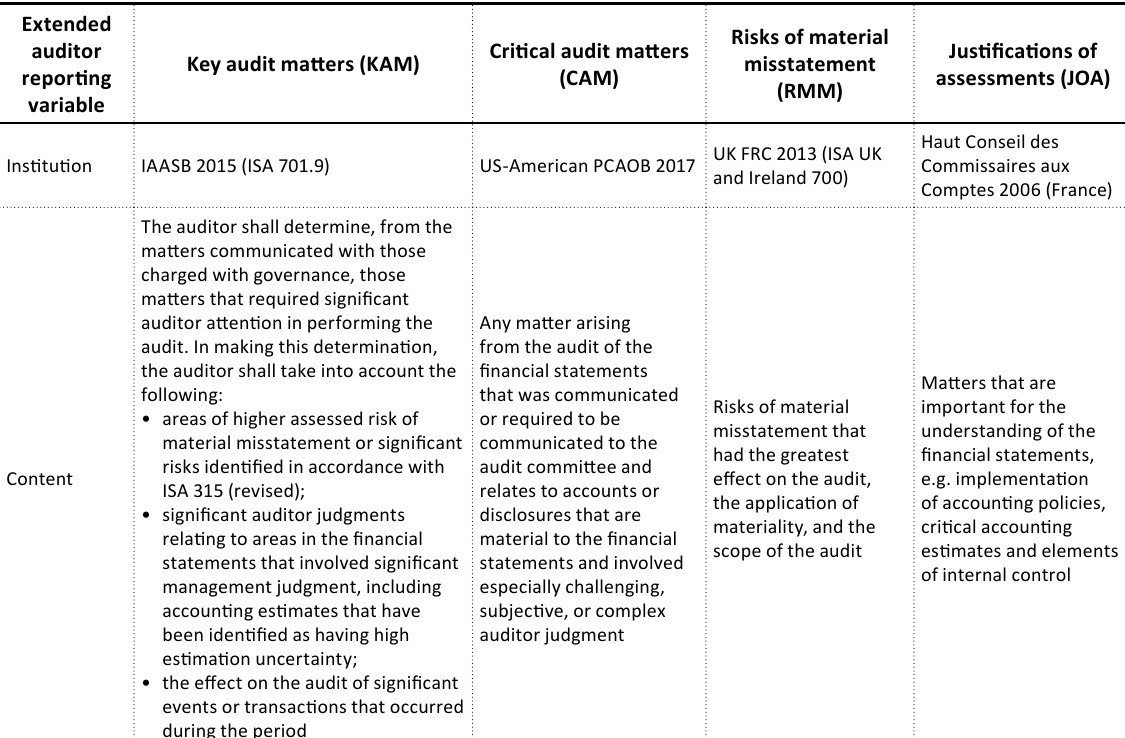
Table 1. KAM and other extended auditor reporting